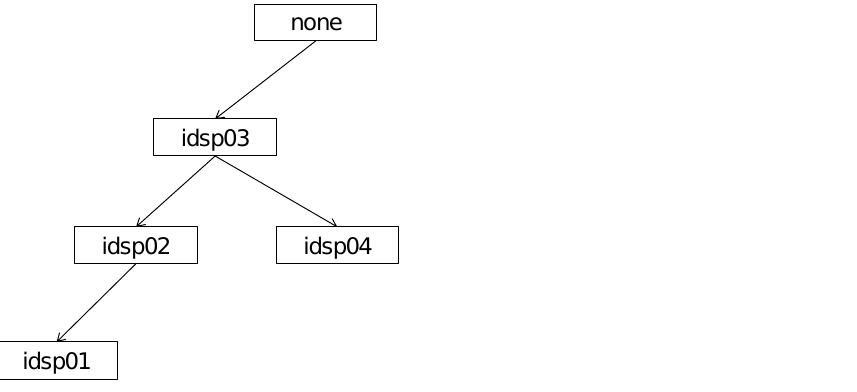
Figure 4. Salesperson hierarchy (see instances in Section 3).